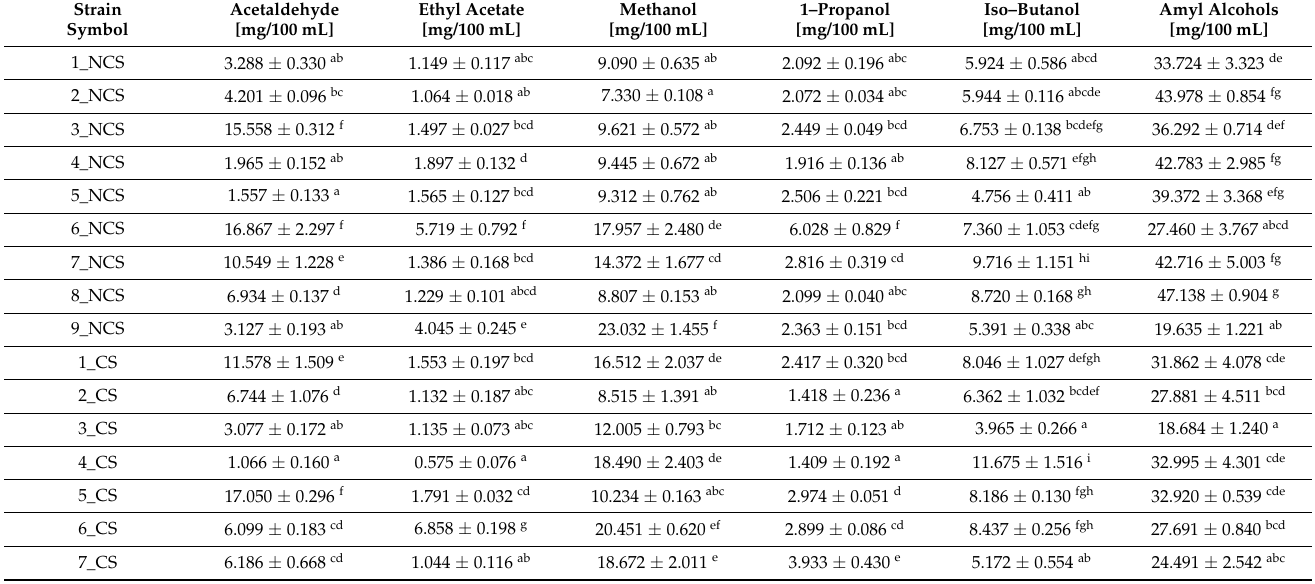
Lowercase letters indicate homogenous groups at a significance level of p ≤ 0.05. Table 9. By-products of fermentation in red